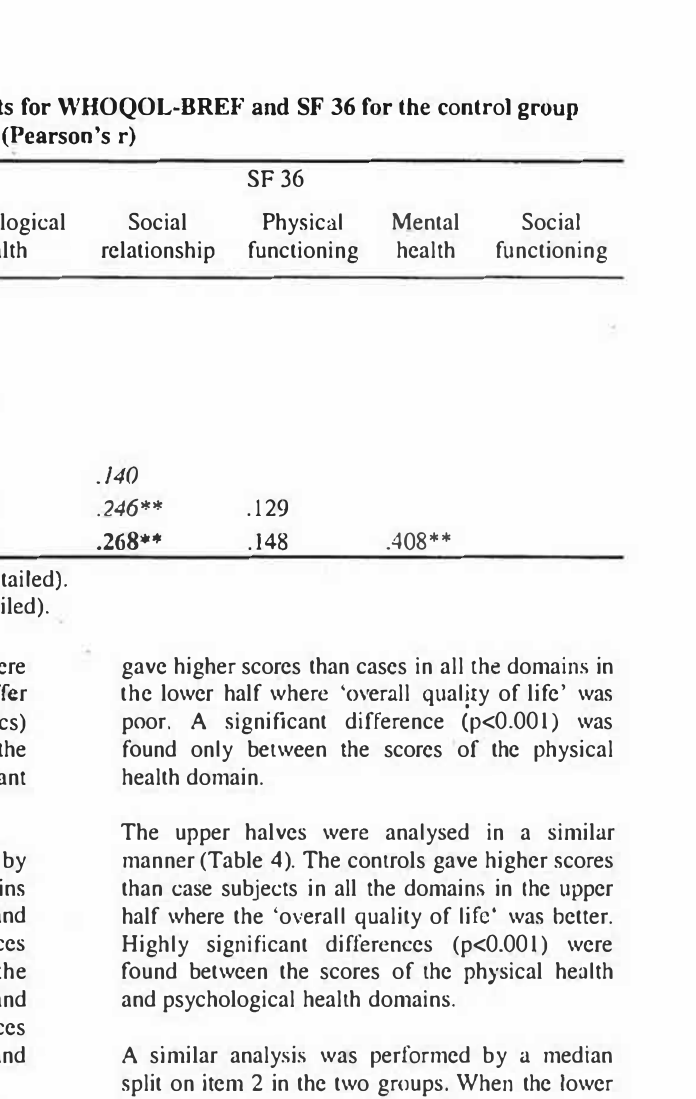
Table 3-Mean scores for WHOQOL-BREF for women with PCOS and for the control group Domain